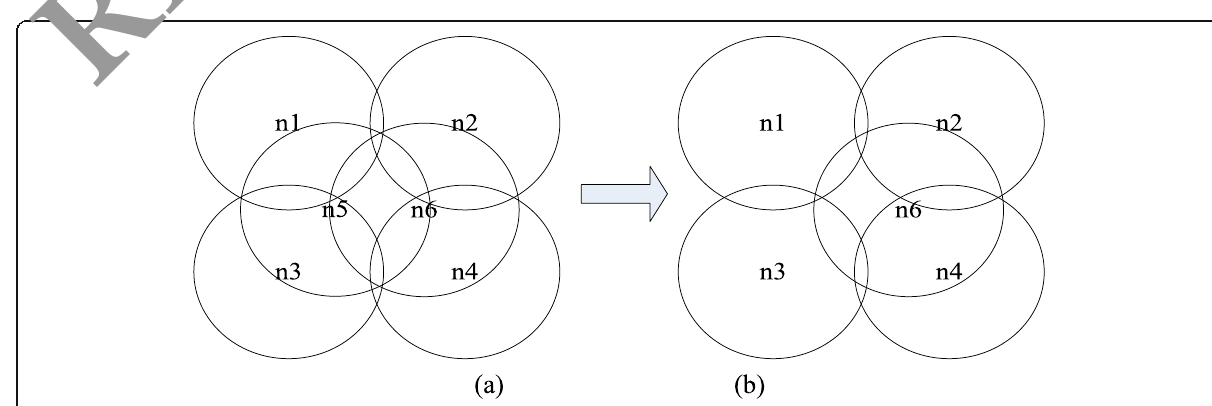
Fig. 1 Distribution model of SNS network platform model. ni (i = 1,2,..., 6) represents different social network